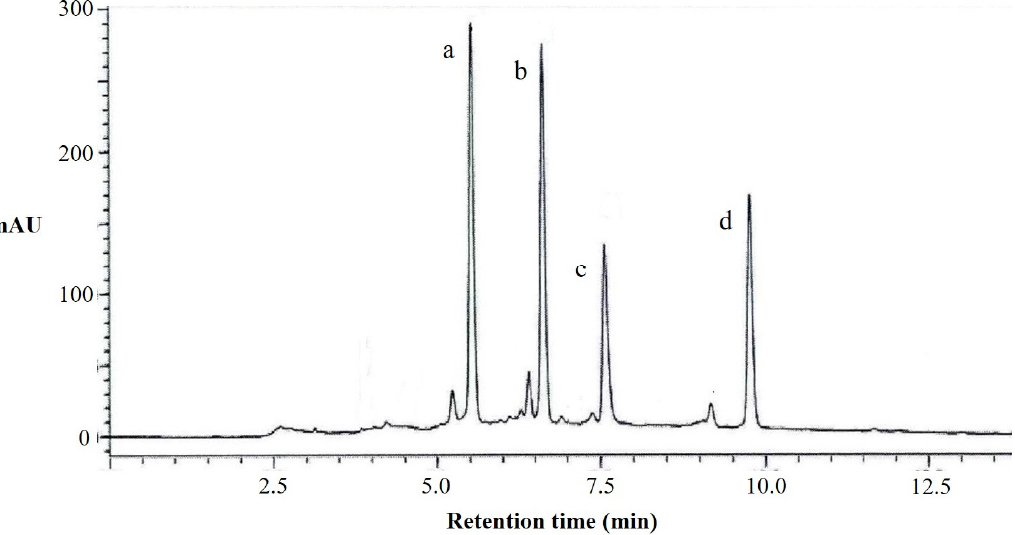
Figure 2. HPLC chromatograms at 330 nm of flavonoids from perilla leaves. a, apigenin 7-O- caffeoylglucoside; b, scutellarein 7-O-diglucuronide; c, luteolin 7-O-diglucuronide; and d, scutellarein 7-O-glucuronide.